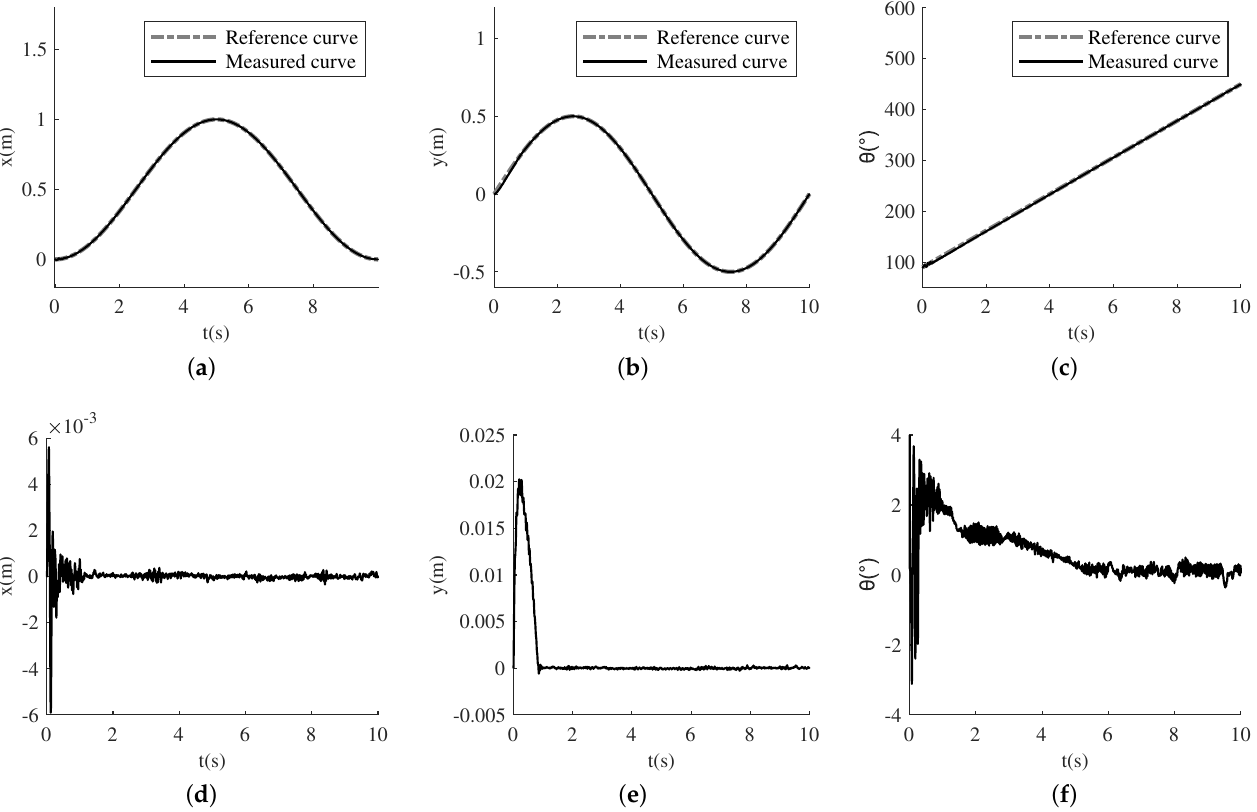
Figure 13. The result of NMPC controller in the simulation experiment. ( a ) X-directional position–time curve in NMPC experiment. ( b ) Y-directional position–time curve in NMPC experiment. ( c ) Orientation–time curve in NMPC experiment. ( d ) Error of X-directional position–time curve in NMPC experiment. ( e ) Error of Y-directional position–time curve in NMPC experiment. ( f ) Error of Orientation–time curve in NMPC